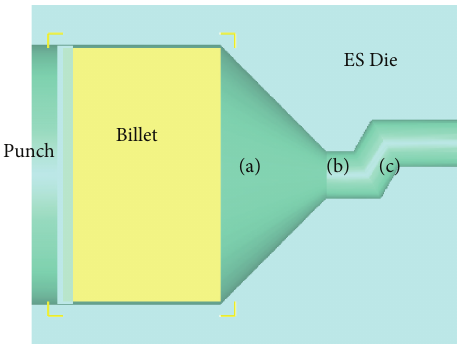
Figure 1: ES die and billet (a) direction extrusion stage, (b) first shearing, and (c) second